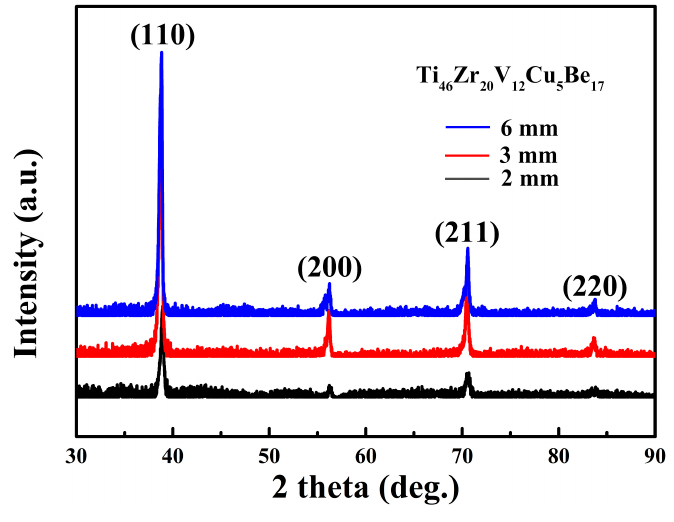
Figure 1. X-ray diffractometry (XRD) patterns of as-cast Ti 46 Zr 20 V 12 Cu 5 Be 17 composites with different diameters.